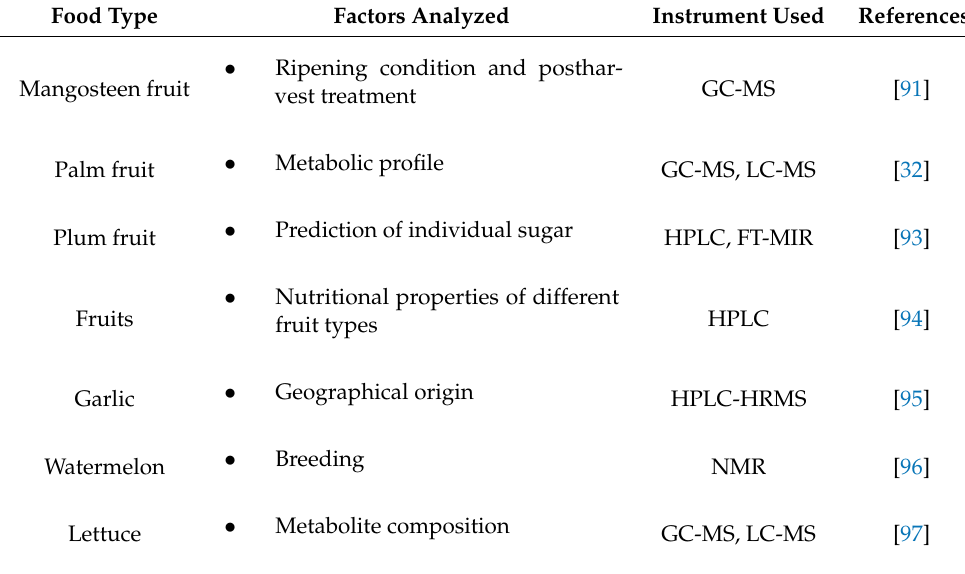
Table 6. Metabolomics approach performed on fruit and vegetable